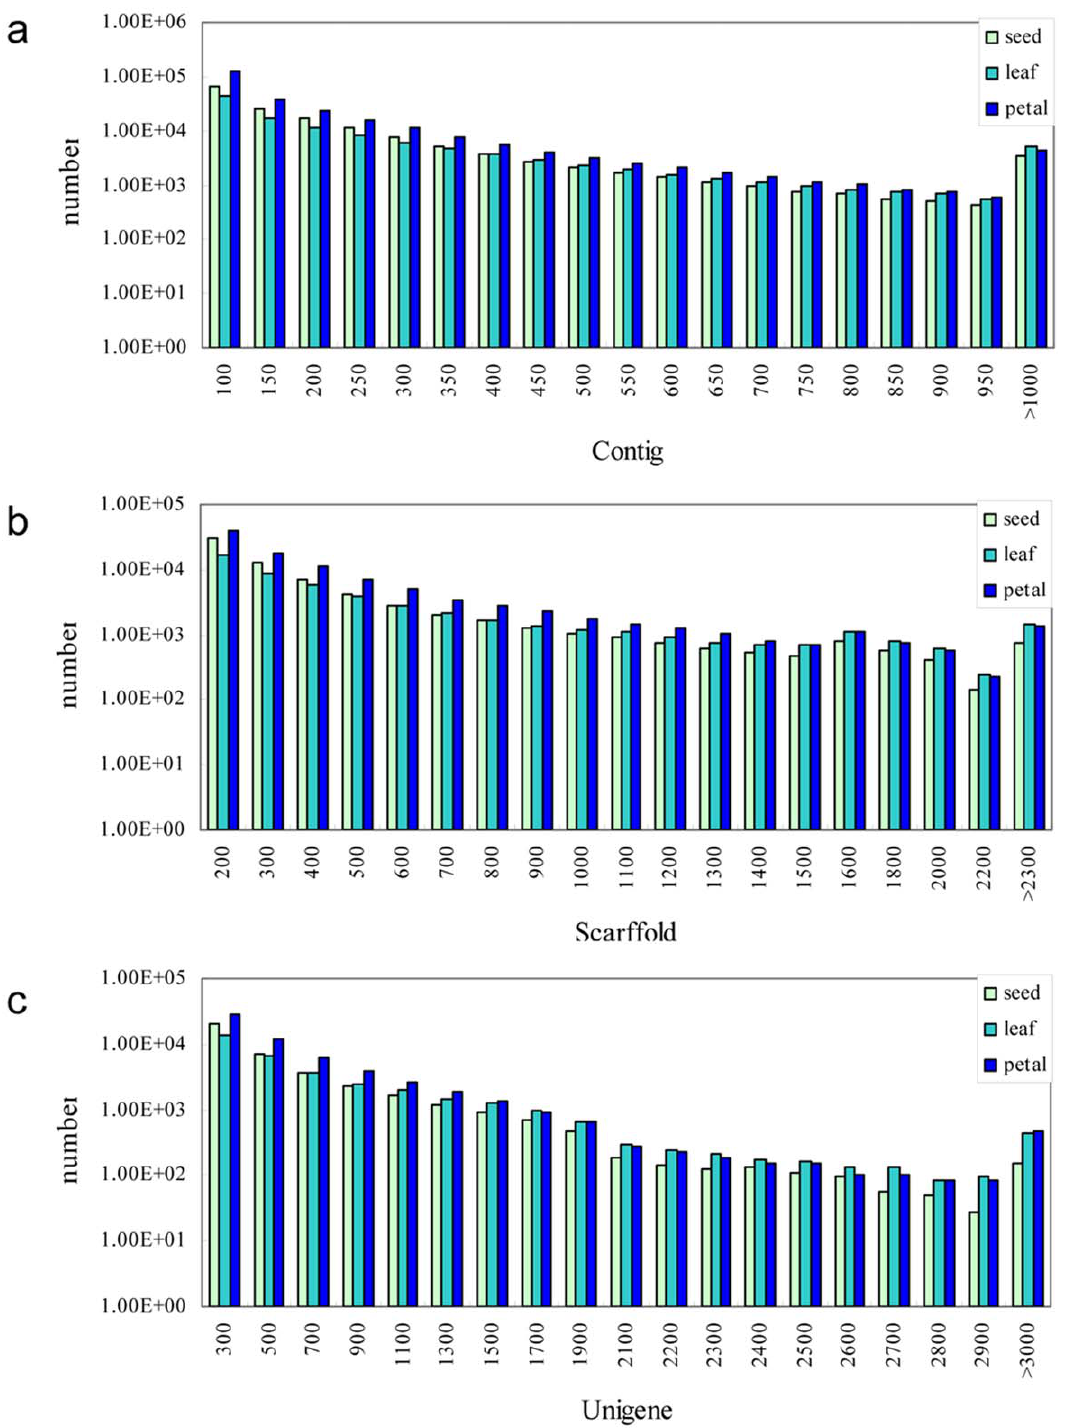
Figure 1. Overview of the sequencing and assembly of the safflower transcriptome. A . Overview of contig assembly. B . Overview of scaffold assembly. C . Overview of unigene assembly. doi:10.1371/journal.pone.0030987.g001 gene83847, unigene120350 and unigene141701, that were annotated as candidate oleosins (table S1). These eleven unigenes may be involved in seed lipid storage and were selected for further analysis. The amino acid sequences of oleosins always have a central hydrophobic domain that is highly conserved between